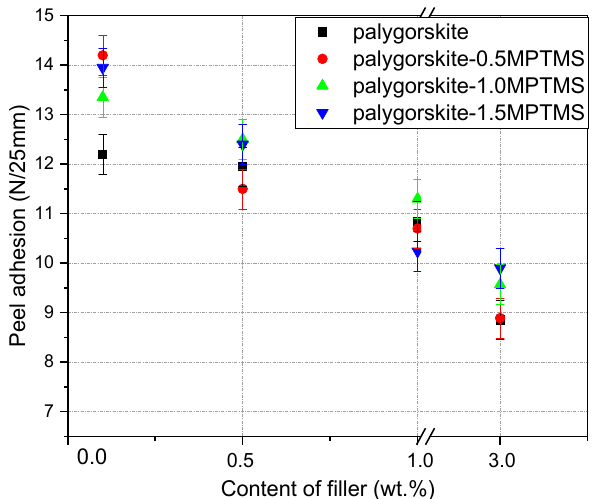
Figure 8. Influence of palygorskite modified by MPTMS addition on Si-PSA tape adhesion.